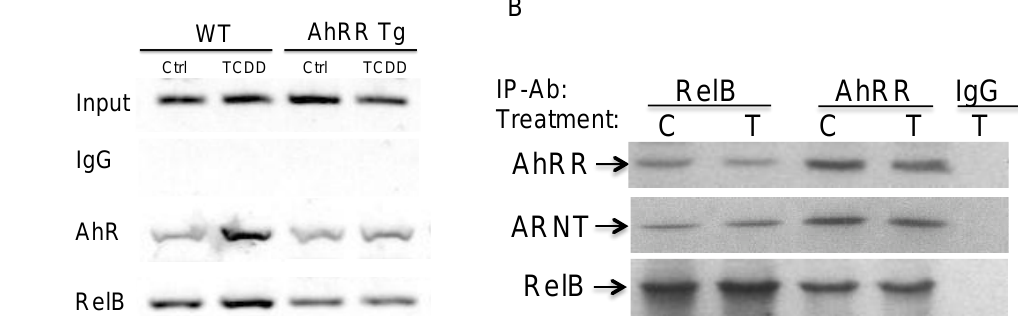
Figure 6. TCDD stimulates the recruitment of AhR and RelB to the RelBAhRE region of the mouse IL-1 β promoter. ( A ) MEF derived from wt and AhRR Tg mice were treated with 1 nM TCDD for 90 min. ChIP assays were performed using AhR- and RelB-specific antibodies followed by PCR analysis with primer pairs covering the specified RelBAhRE region of mouse IL-1 β promoter. ( B ) Association of AhRR with ARNT and RelB. Co-IP of AhRR, ARNT, and RelB with RelB and AhRR antibody. MEF from wt and AhRR Tg mice were treated with 1 nM TCDD (T) or DMSO (C) for 90 min and cell lysates were used for co-IP. Western blot analysis was performed to detect specific association of AhRR with ARNT and RelB. Rabbit lgG was used as negative control.